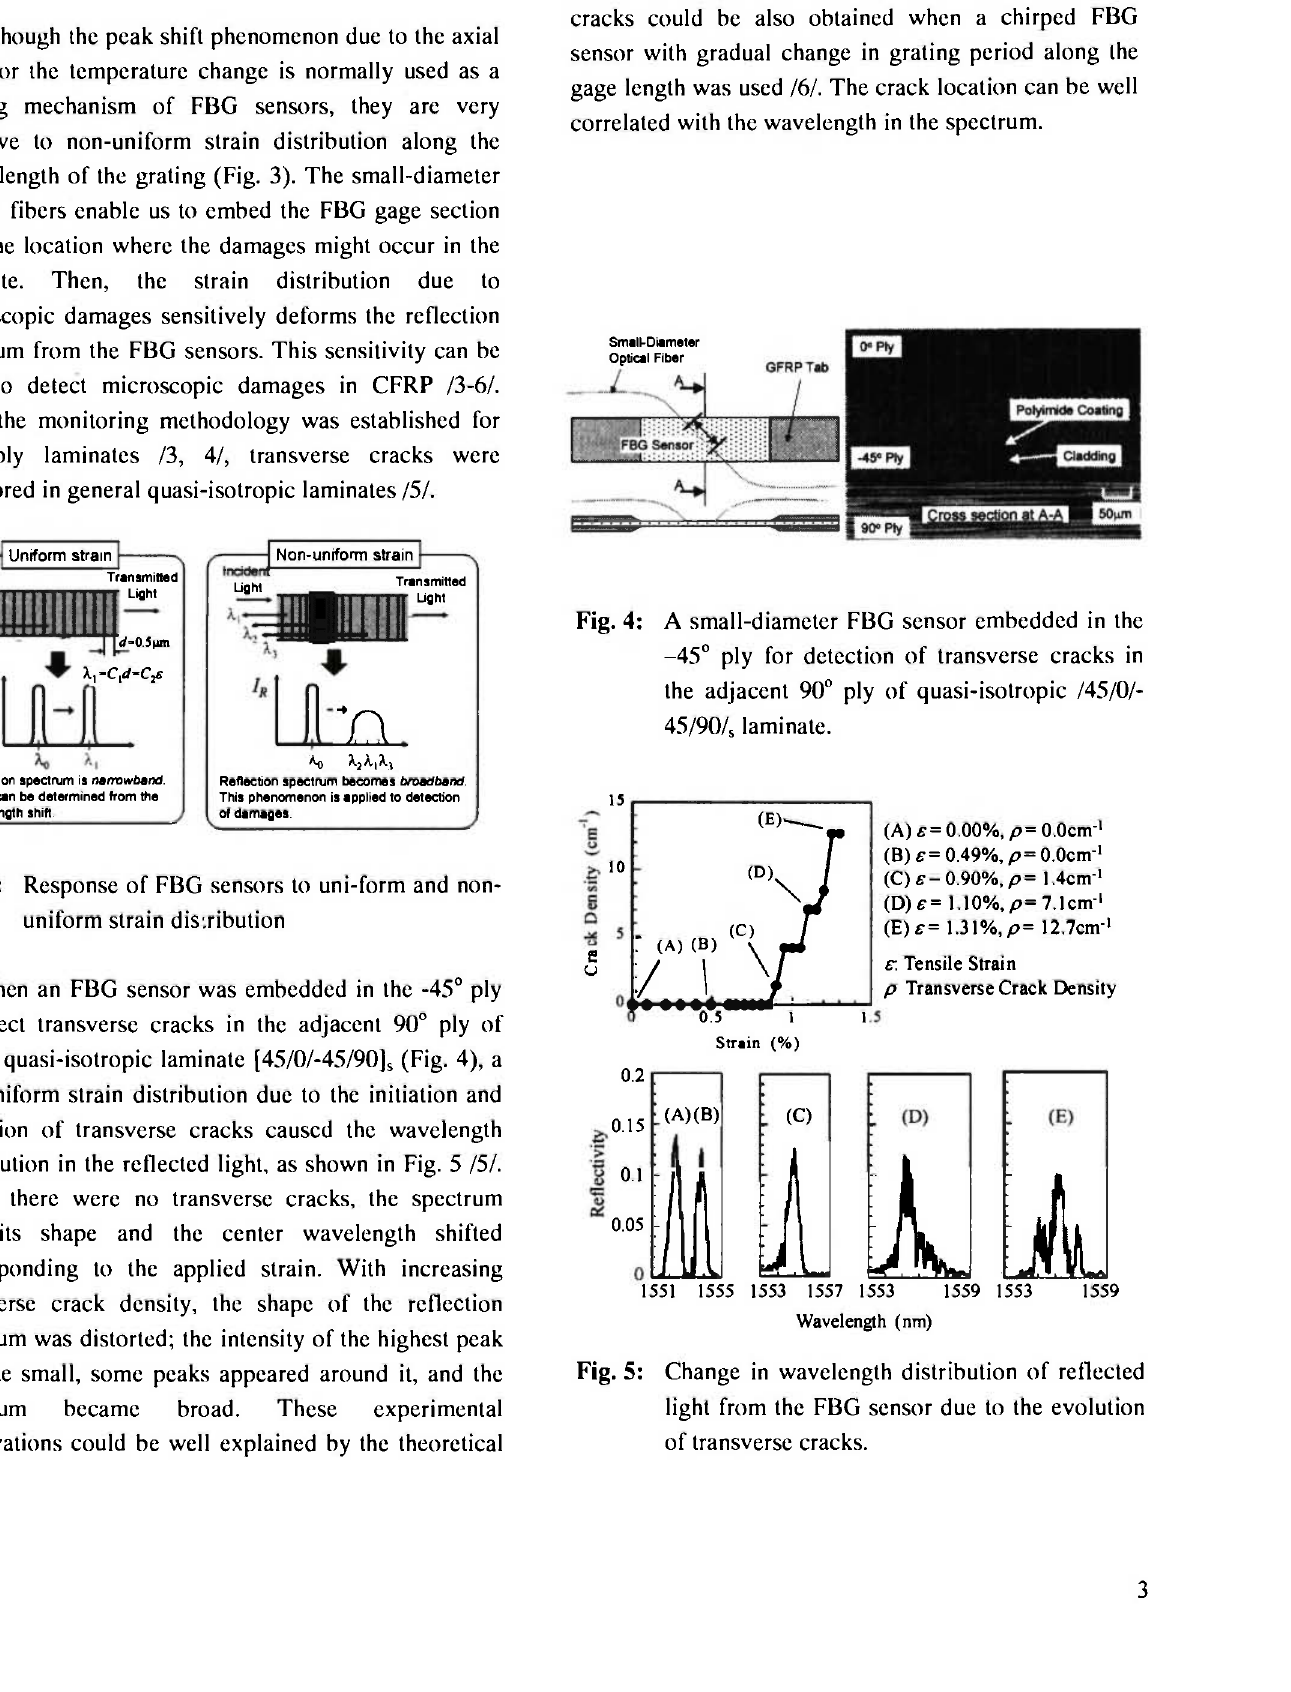
Fig. 5: Change in wavelength distribution of reflected light from the FBG sensor due to the evolution of transverse